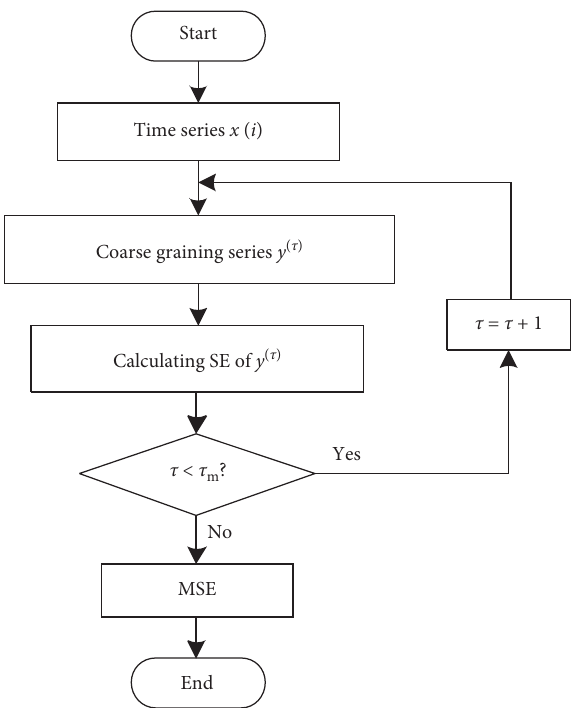
Figure 5: Flowchart of the MSE